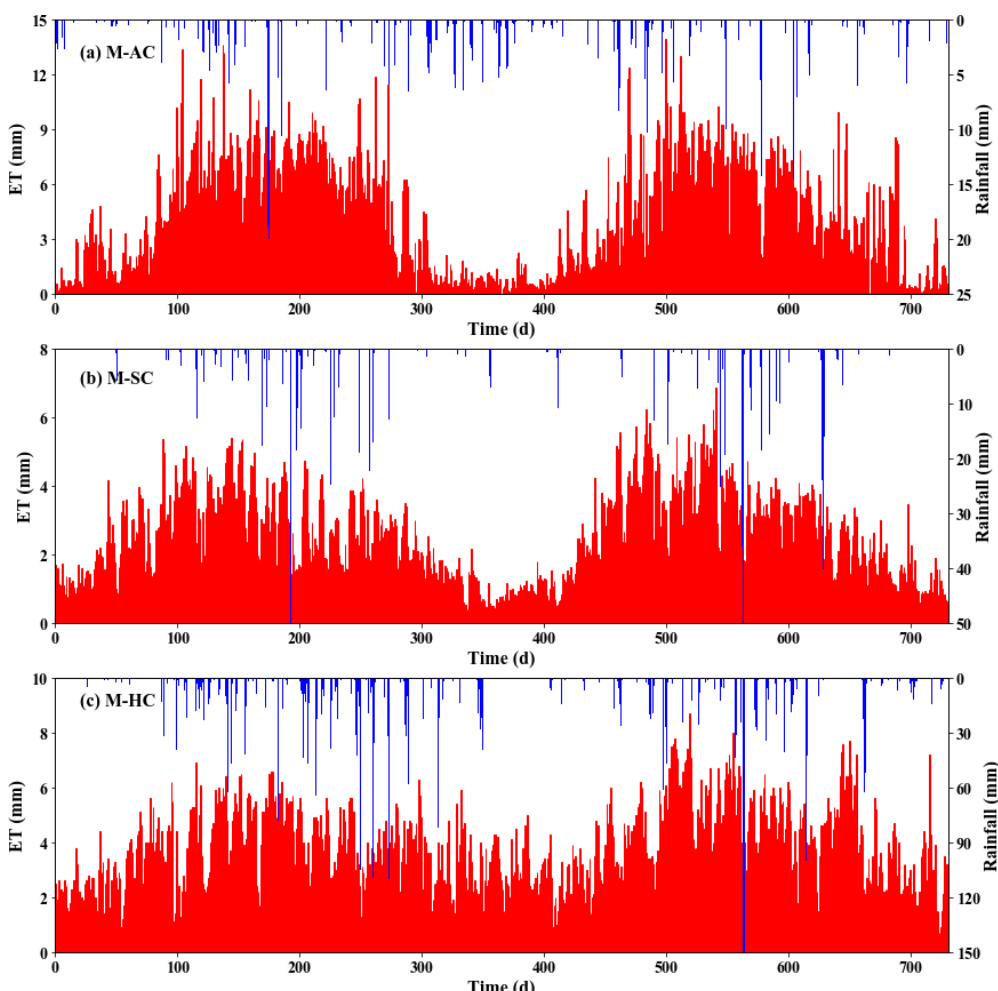
Figure 2. Synthetic rainfall (blue bars) and potential evaporation (red bars) of three typical climates: (a) arid climate, (b) semi-arid climate and (c) humid climate. It should be noted that the meteorological data of simulation period are from day 366 to day